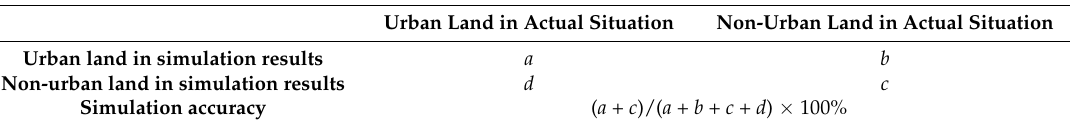
Table 5. Simulation accuracy calculation method in the error matrix.